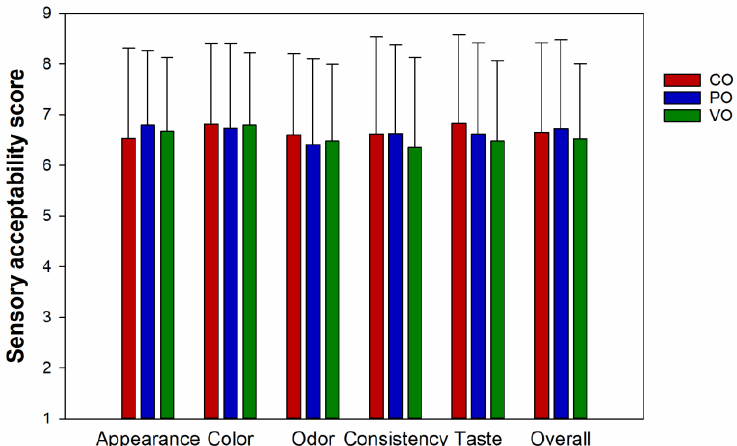
Figure 5. Sensory acceptability score of date syrups from juice extracted without enzyme (CO) and with the aid of Pectinex (PO) or Viscozyme (VO) followed by evaporation using open heating. Values are means and standard deviations of 60 panelists ( n = 60). There was no significant difference between means for each sensory attribute of the 3 samples ( p > 0.05).